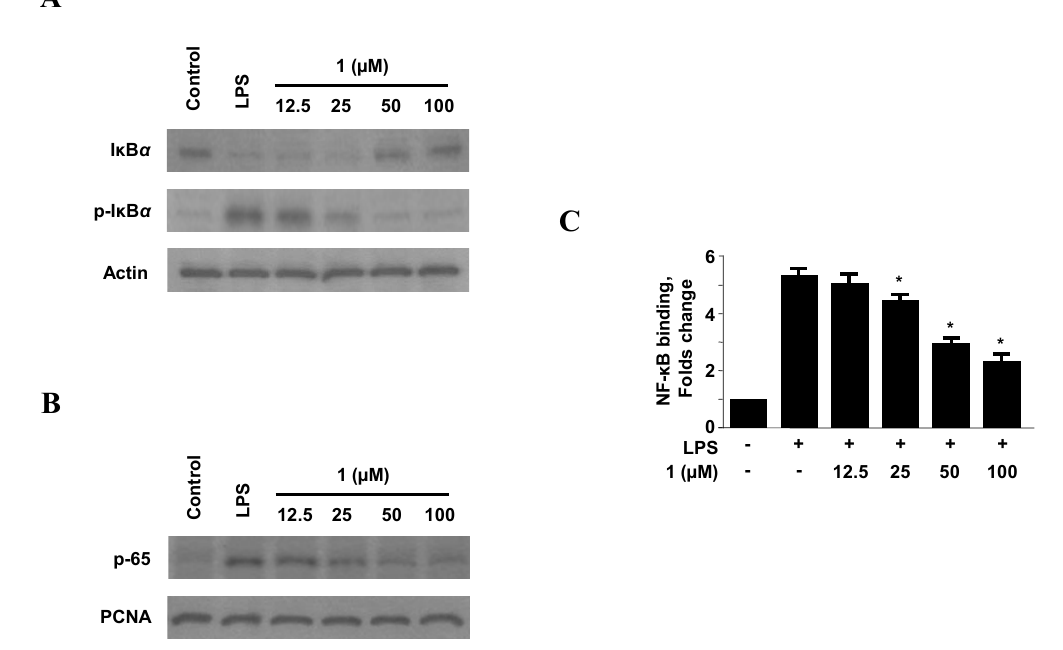
Figure 5. Effect of neoechinulin A ( 1 ) on I κ B- α phosphorylation and degradation (A), NF- κ B activation (B), and NF- κ B DNA-binding activity (C). RAW264.7 macrophages were